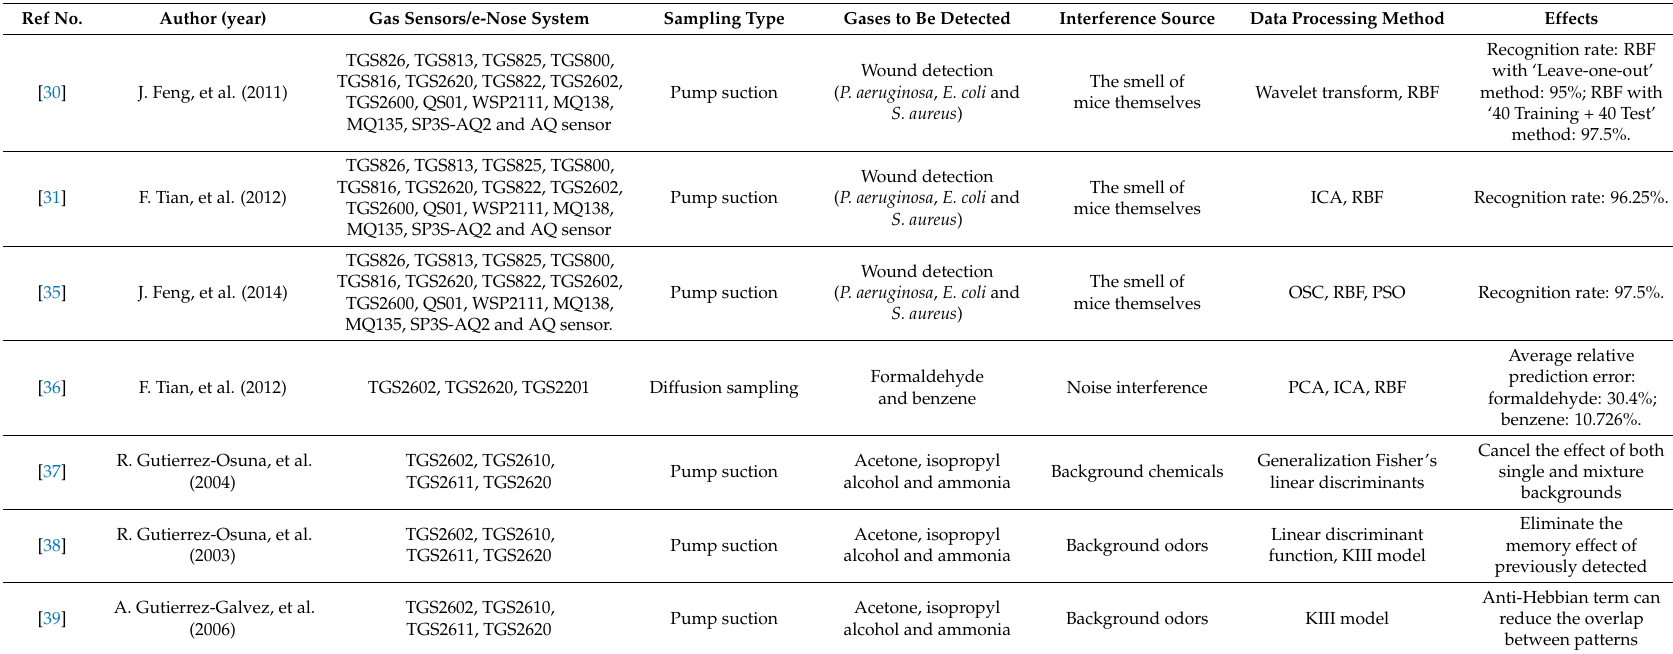
Table 2. Methods for background interference